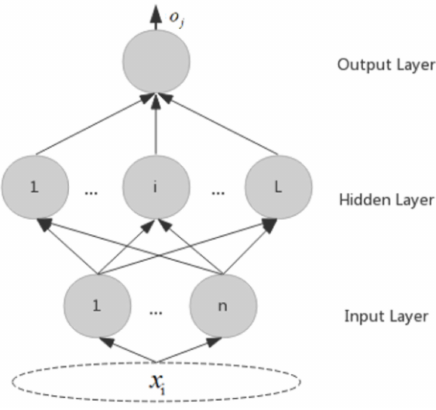
Figure 2. Single hidden layer neural network